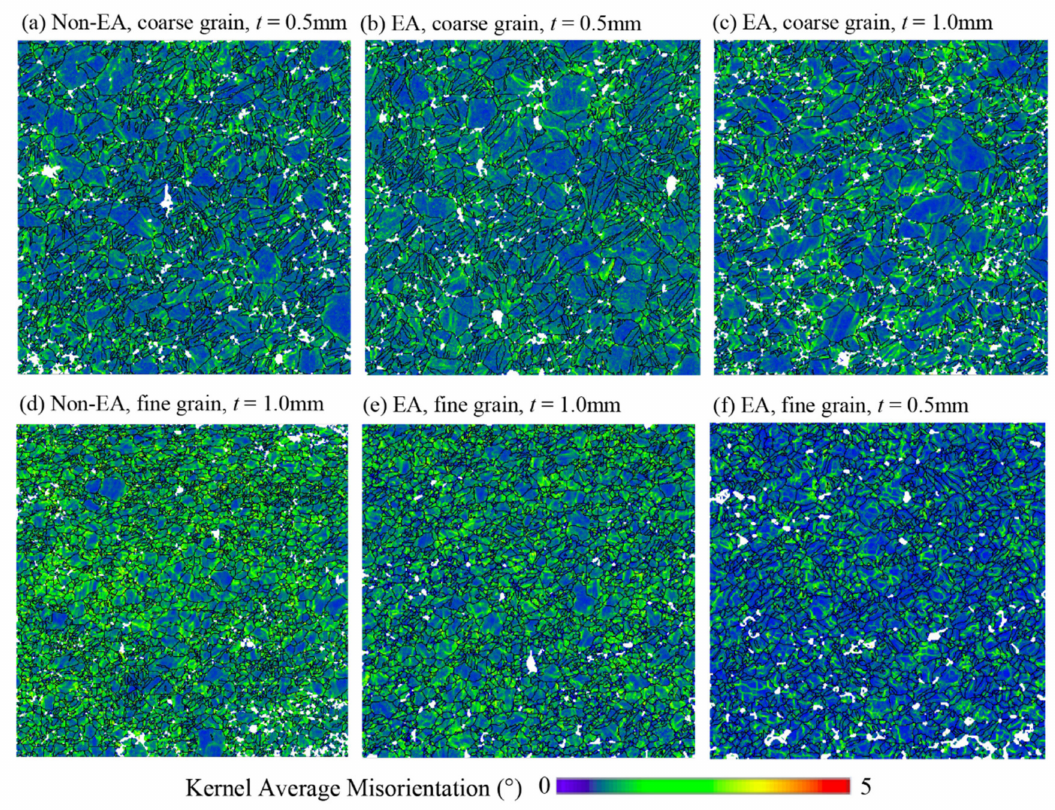
Figure 5. KAM maps of the samples strained to 10% tensile deformation under various deformation conditions. ( a ) Non-EA, coarse grain, t = 0.5 mm; ( b ) EA, coarse grain, t = 1.0 mm; ( c ) EA, coarse grain, t = 0.5 mm; ( d ) non-EA, fine grain, t = 1.0 mm; ( e ) EA, fine grain, t = 1.0 mm; ( f ) EA, fine grain, t = 0.5